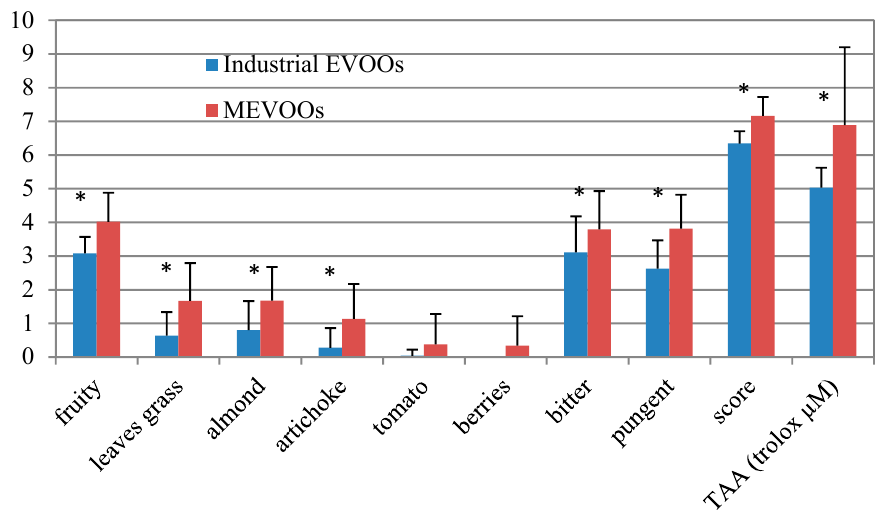
Figure 3. Comparison between the results obtained from sensory analysis and total antioxidant activity assay (TAA) of the 79 monovarietal extra virgin olive oils (MEVOOs) samples investigated (14 Ascolana tenera, 14 Coroncina, 15 Mignola, 17 Piantone di Mogliano, 19 Raggia) and 24 industrial extra virgin olive oils (EVOOs) purchased from supermarkets. Positive bars indicate standard deviation. Significant differences between Industrial EVOOs and MEVOOs are highlighted by the asterisk ( p < 0.05, One-way ANOVA and Tukey’s test for a pairwise comparison).